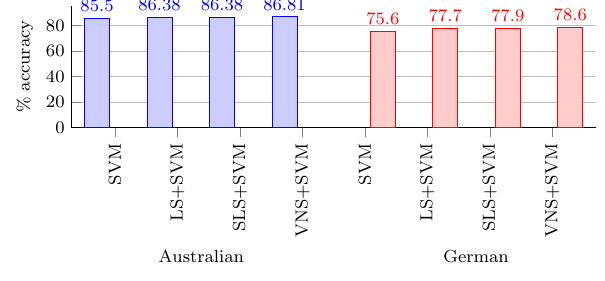
Fig. 5 Accuracy% comparison